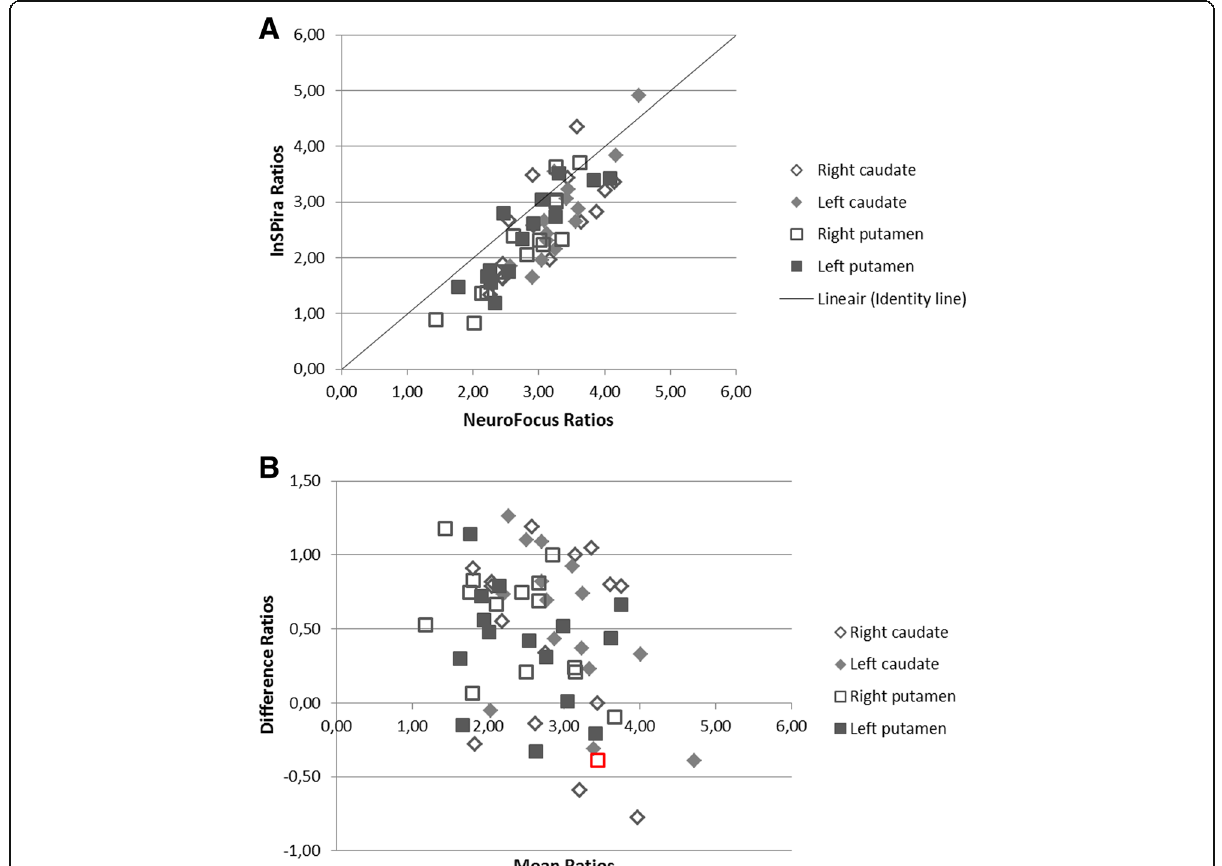
Fig. 4 Scatterplot of [ 123 I]FP-CIT binding ratios in the caudate nucleus and putamen on the InSPira and NeuroFocus system in patient data. a Scatterplot of specific to non-specific [ 123 I]FP-CIT binding ratios in the caudate nucleus and putamen of data obtained on the InSPira ( y -axis) and NeuroFocus ( x -axis) system for the human study. b Bland-Altman plot with mean ratios for the two systems on the x -axis and the differences between the two systems on the y -axis (subtracting InSPira from NeuroFocus ratios). The values exceeding 1.96 SD difference (for that ROI) are displayed in red. One value exceeded our pre-defined limits of agreement (1.96 SD difference). This was right putamen ratio for a subject whose [ 123 I]FP-CIT SPECT scan was visually rated as abnormal (PD-like) on both systems